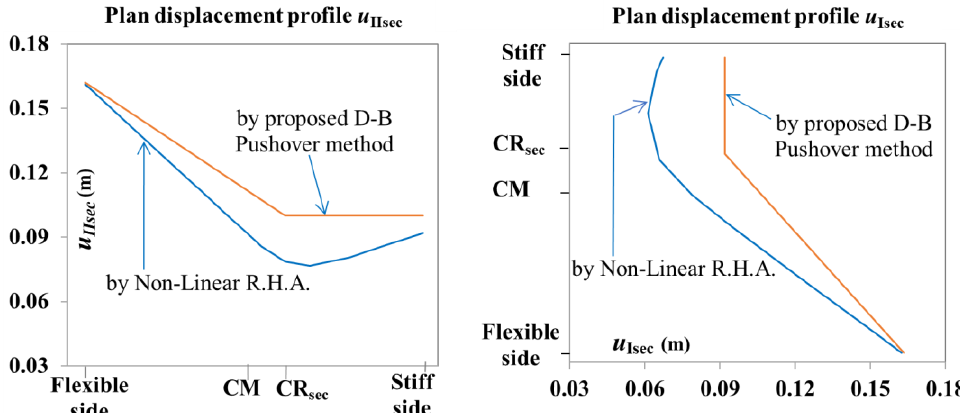
Fig. 11. Plan inelastic displacement profile along the “Capable Near Collapse Principal Axes” 𝛪𝐼 and 𝛪 (right) resulted from the proposed Displacement-Based procedure. Comparison with the seismic sec